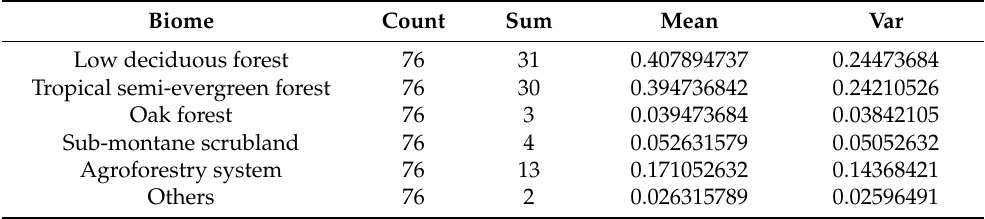
Table 7. Statistical summary.